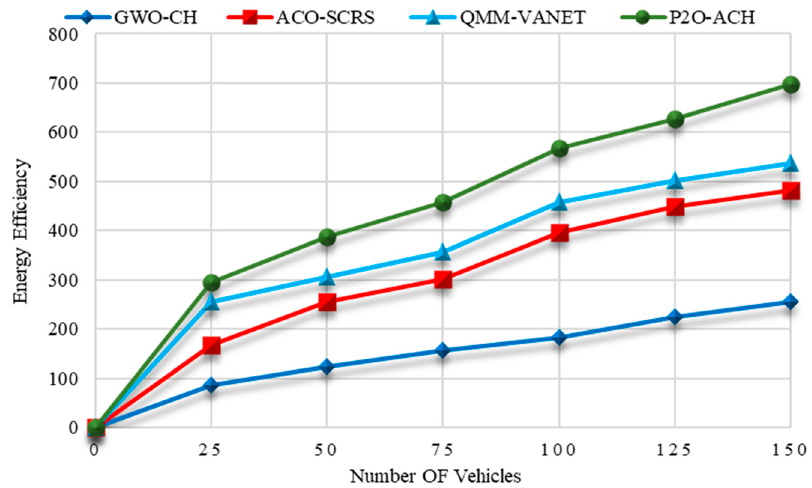
Figure 2. Energy Efficiency Calculation.